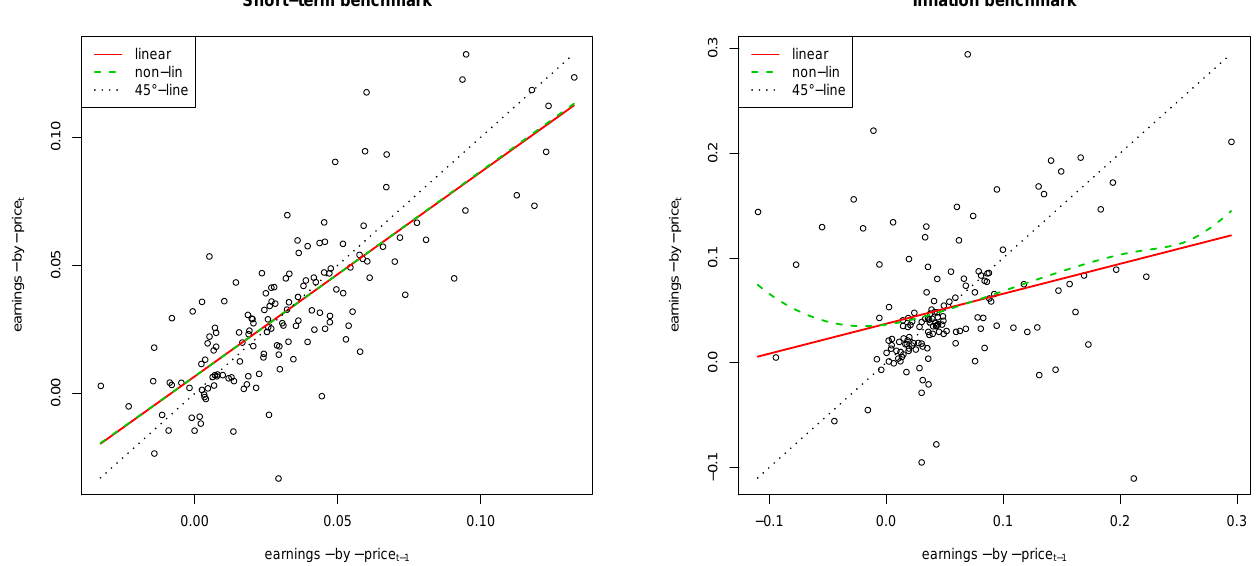
Figure 5. Autoregressive behavior of the earnings-by-price ratio. ( Left ) Short-term interest rate benchmark. ( Right ) Inflation benchmark. Shown are estimates of a linear function (solid red), the local-linear smoother (dashed green), and the 45 ◦ -line (dotted black). Period: 1872–2020. Data: annual S&P